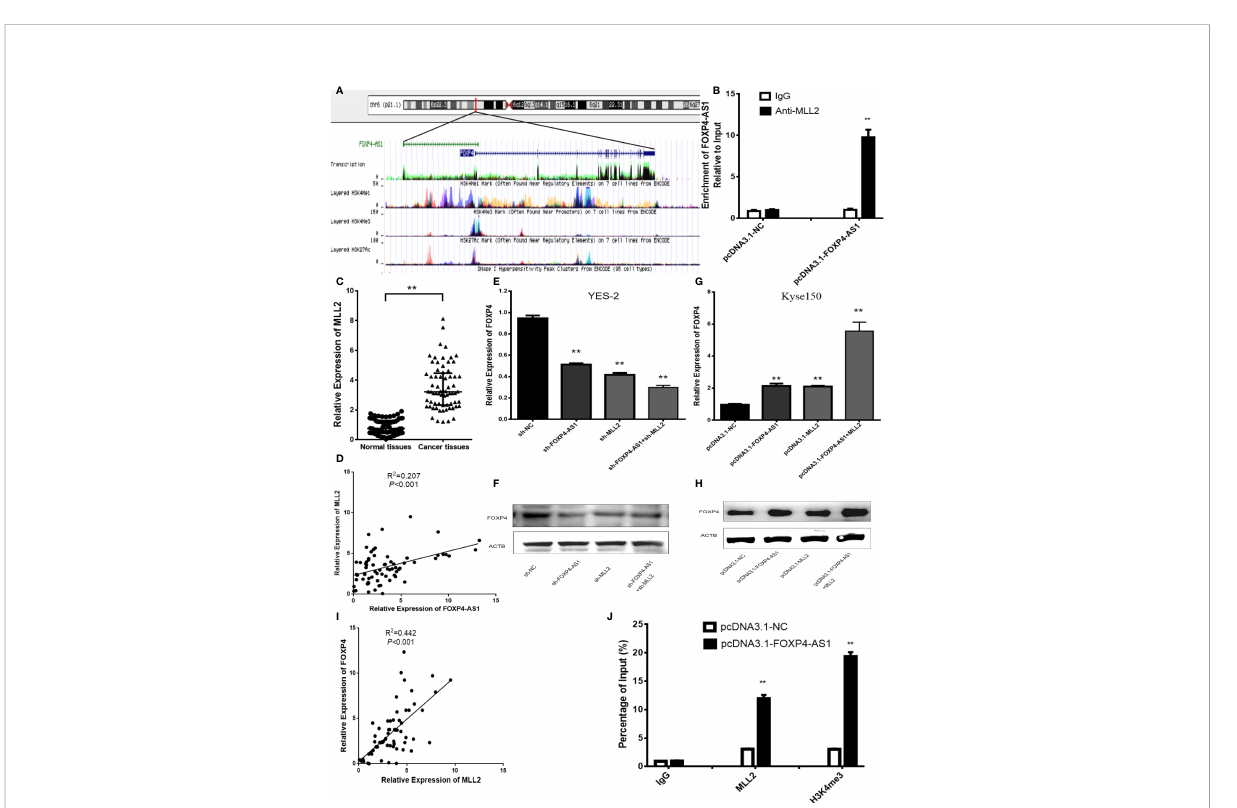
FIGURE 4 FOXP4-AS1 upregulates FOXP4 expression through interacting with MLL2. (A) Epistatic regulatory maps of FOXP4 and FOXP4-AS1 by UCSC. (B) The binding of FOXP4-AS1 to MLL2 in Kyse150 by RIP. (C) The expression of MLL2 in ESCC by qRT – PCR. (D) The association between FOXP4- AS1 and MLL2 by qRT – PCR. FOXP4 mRNA (E, G) and protein (F, H) by coexpressing FOXP4-AS1 and MLL2. (I) The correlation between FOXP4- AS1 and MLL2 by the qRT – PCR. (J) FOXP4-AS1 increased MLL2 and H3K4me3 enrichment in the FOXP4 promoter as determined by ChIP assay. ** p <